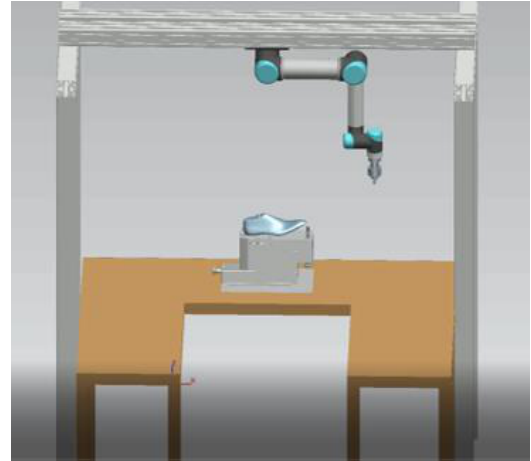
Figure 4. UR5e mounted on the profile structure.